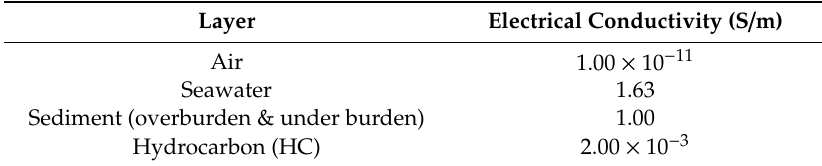
Figure 1. Stratified illustration of the SBL models. There are two types of SBL models: ( a ) SBL model with the presence of hydrocarbon layer; ( b ) SBL model without the hydrocarbon layer. For the target model, depth of the hydrocarbon (thickness of overburden) was varied, which were 1000 m, 2000 m, and 3000 m. The height and length of both the SBL models were 5000 m and 20,000 m, respectively. Table 1. Electrical conductivity values used in the SBL modelling were taken from [36]. Note that electrical resistivity is the inverse of electrical